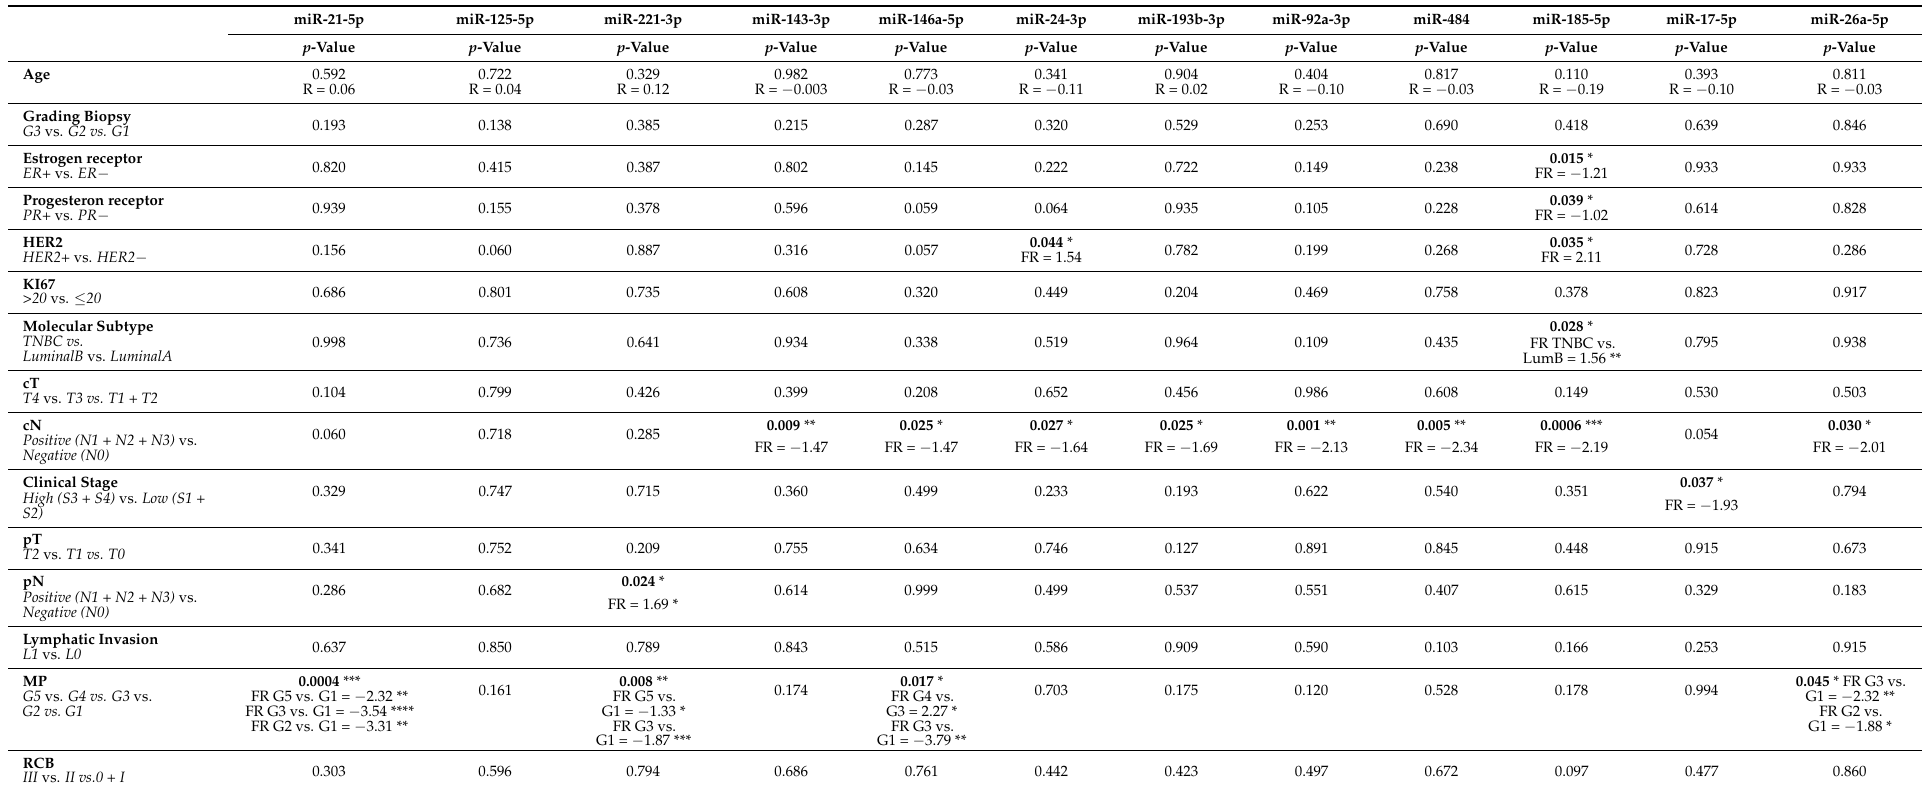
Table 3. Associations between clinical-pathological features and sEVs miRNA